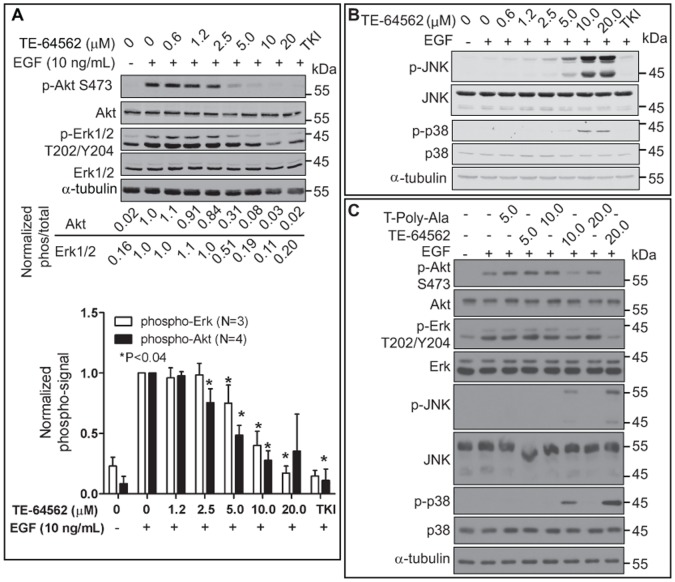
TE-64562 effects downstream EGFR signaling.(A) Serum starved MDA-MB-231 cells were treated with TE-64562 (0.6, 1.2, 2.5 5.0 10 and 20 µM), an EGFR specific tyrosine kinase inhibitor (2.0 µM, TKI) or vehicle for 30 minutes, followed by EGF treatment (10 ng/mL) for 10 minutes. Cell lysates were collected and analyzed by Western blot for (A) phospho-Akt (S273), total Akt, phospho-Erk (p44/p42, T202/Y204) and total Erk. Blots were stripped and re-probed for α-tubulin. The Erk (N = 3) and Akt (N = 4) data from separate experiments, all of which are shown in Figure S6, were analyzed. The normalized (ratio of phospho to total intensity) data were plotted as mean values from with the error bars representing the standard error of the mean. The significant differences (*P<0.04) were assessed between each treatment condition and the EGF-treated control (lane 2). (B) Serum starved MDA-MB-231 cells were treated with TE-64562 (0.6, 1.2, 2.5 5.0 10 and 20 µM), an EGFR specific tyrosine kinase inhibitor (2.0 µM, TKI), Tat (20 µM) or vehicle for 30 minutes, followed by EGF treatment (10 ng/mL) for 10 minutes. Results represent one of three independent experiments. Also see Fig. S6. (C) Serum starved MDA-MB-231 cells were treated with TE-64562 (5.0, 10.0 and 20.0 µM) or T-Poly-Ala control peptide (5.0, 10.0 and 20.0 µM) or vehicle for 30 minutes, followed by EGF treatment (10 ng/mL) for 10 minutes. Results are representative of three independent experiments.